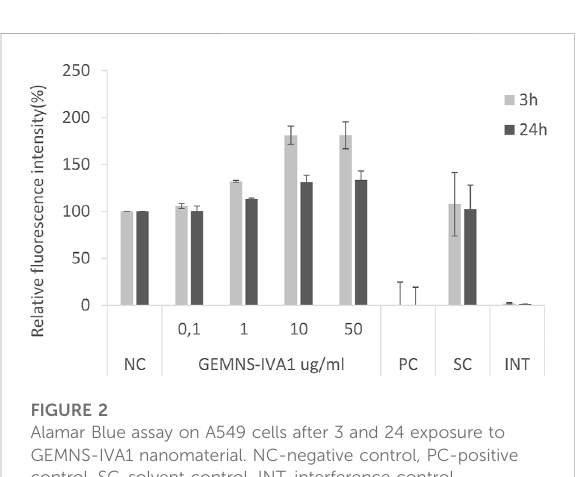
FIGURE 2 Alamar Blue assay on A549 cells after 3 and 24 exposure to GEMNS-IVA1 nanomaterial. NC-negative control, PC-positive control, SC-solvent control, INT-interference